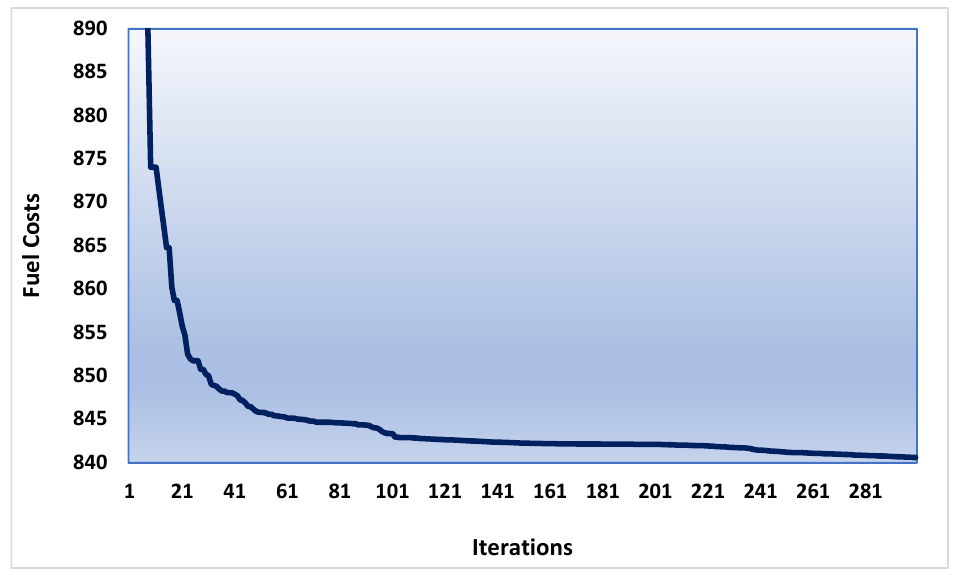
Figure 2. Convergence curves of TLBA for the minimization of the TFCs of the IEEE 30-bus network.